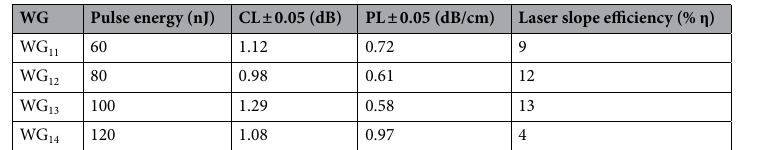
Table 3. Measured CL, PL and laser slope efficiency in the fundamental mode of the 5 MHz written WGs in Yb 3+ : GPGN glass at 1550 nm. FL for the Yb 3+ :GPGN glass is (0.73 ± 0.05) dB. PL is the WG PL calculated from TL using PL = TL/d where d = 1.05 cm is the length of the WGs.